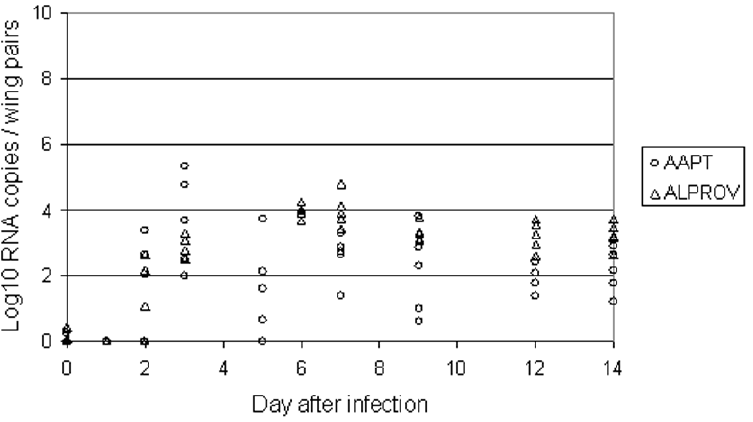
Figure 2. CHIKV dissemination in Aedesalbopictus Providence (ALPROV) and Aedesaegypti Petite-Terre (AAPT). At different days after oral infection, viral dissemination was measured by quantification of viral RNA in mosquito wings of 5 females by real-time